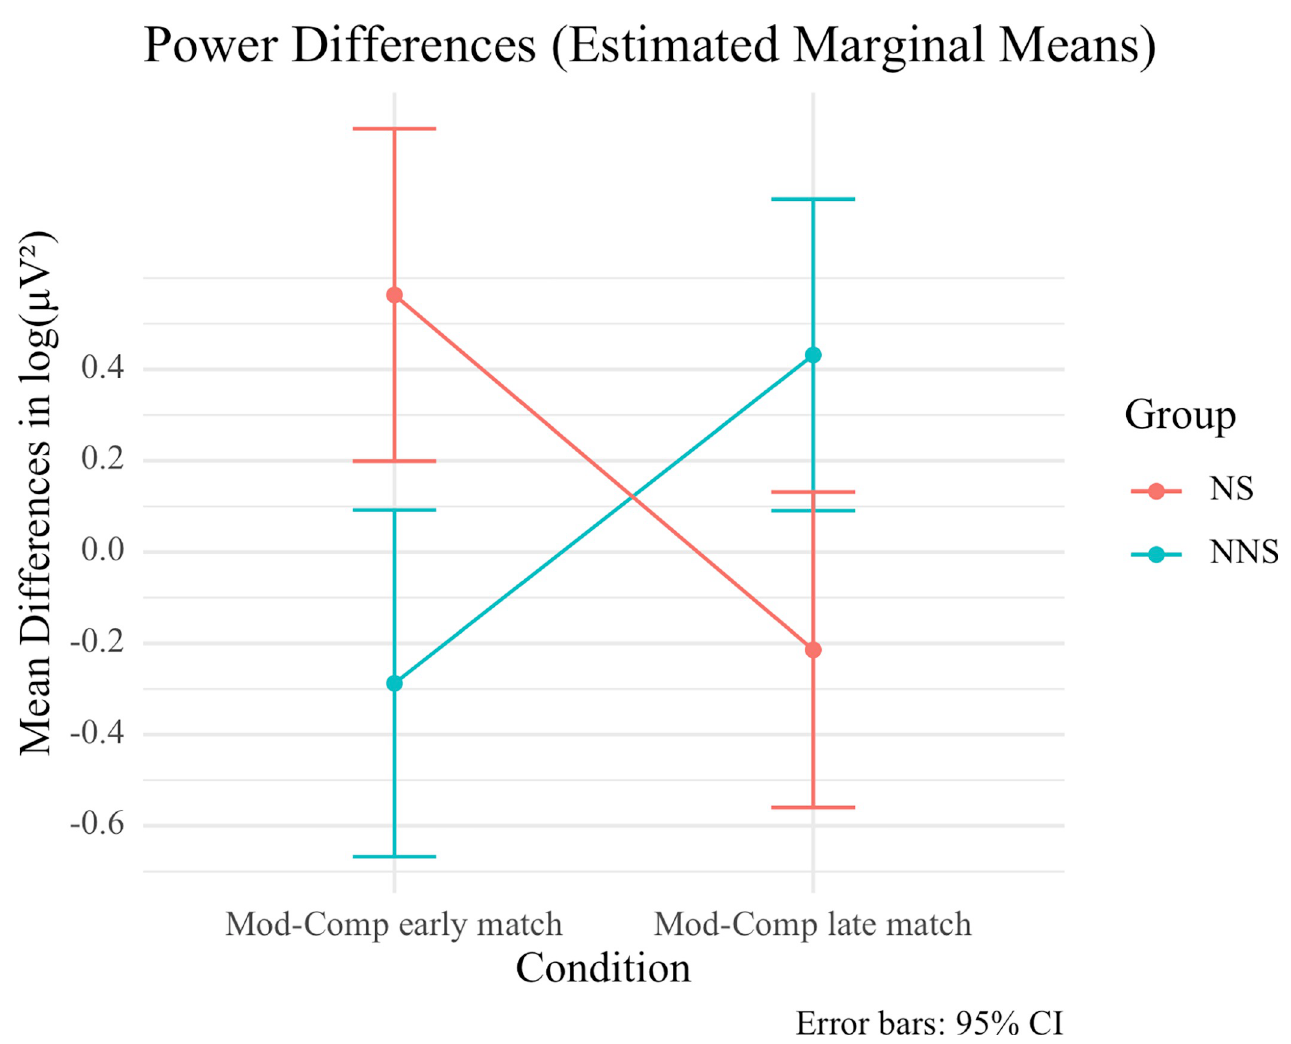
Fig 6. Interaction of Mod-Comp Contrasts in Anaphora ([(2a)—(2b)]—[(2c)—(2d)]) with Group at Bridge Verb dit ‘said’ at 18-19Hz.